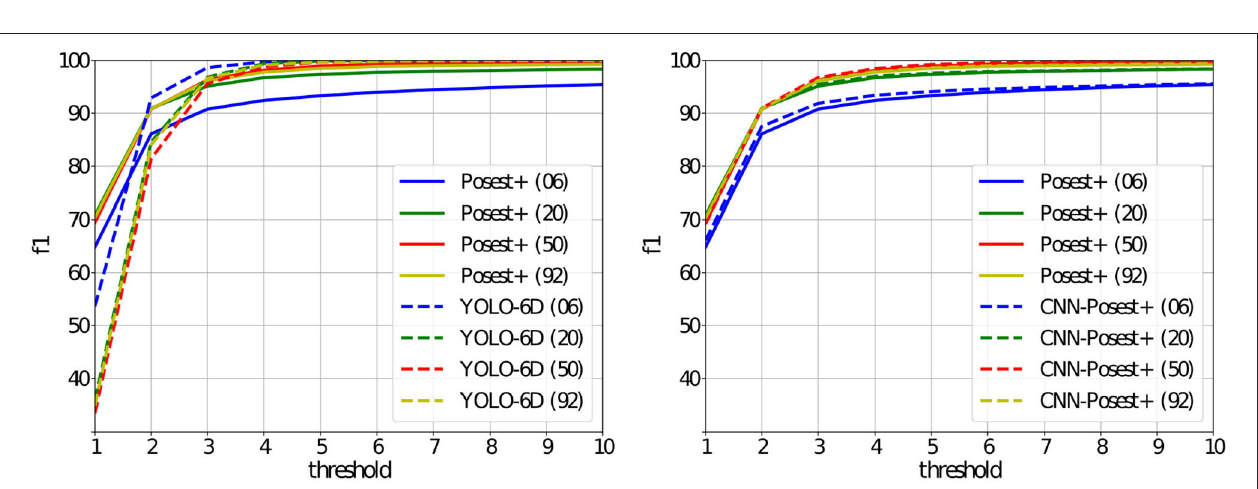
FIGURE 4 | YCB92 f 1 ( t ) score computed for different accuracy thresholds (less than tcm and t ◦ ). Only the networks trained with the 20 % train/validation split are shown. Left : Posest+ vs. YOLO-6D, Right : Posest+ vs. CNN-Posest+.